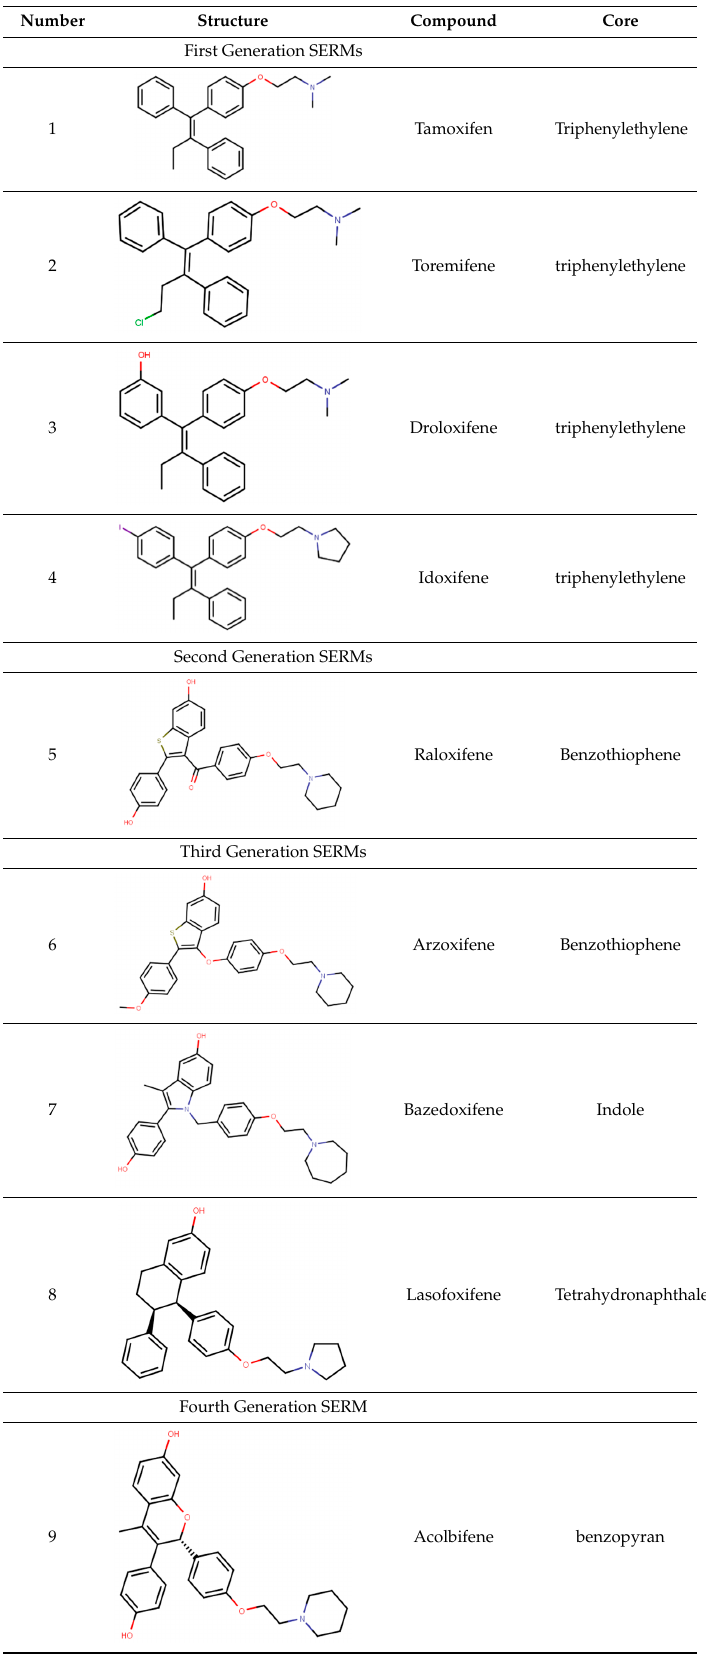
Table 1. List of notable Selective estrogen receptor modulators.